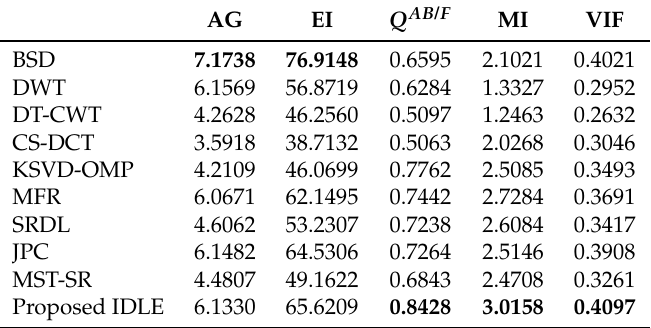
Figure 6. CT-MRI Image Fusion Comparative Experiments, ( a ) is the CT source image; ( b ) is the MRI source image; and ( c )–( l ) are the fused images of BSD, DWT, DT-CWT, CS-DCT, KSVD-OMP, MFR, SRDL, JPC, MST-SR, and the proposed IDLE respectively. Table 1. Objective Evaluations of CT-MRI Image Fusion Comparative